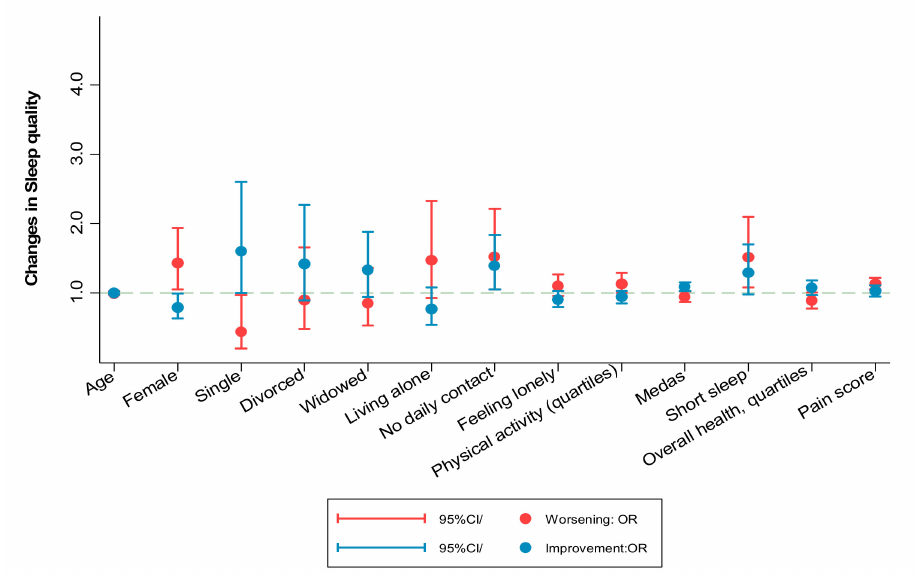
Figure 4. Prospective association between baseline participant characteristics and changes in poor sleep quality score during